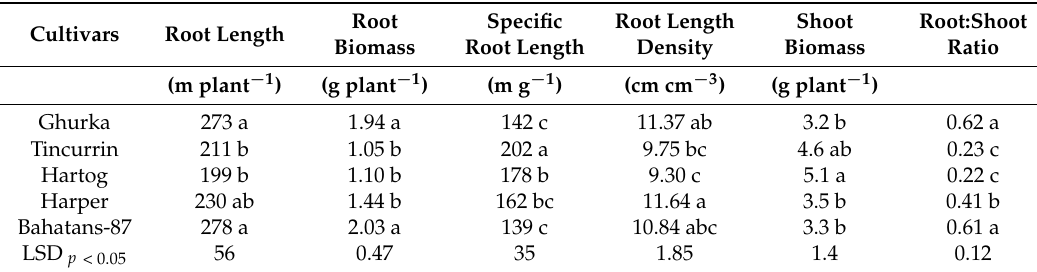
Table 4. Root length, root biomass, specific root length, root length density, shoot biomass and root:shoot ratio of five wheat cultivars at harvest (63